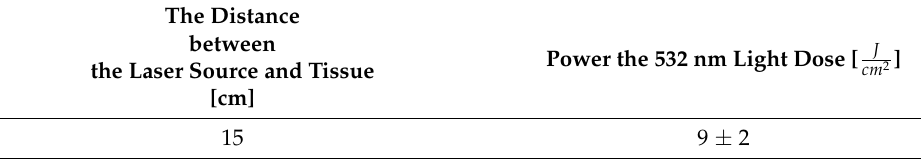
Table 3. Results of optimization of the distance between the laser light source and the sample. The Distance